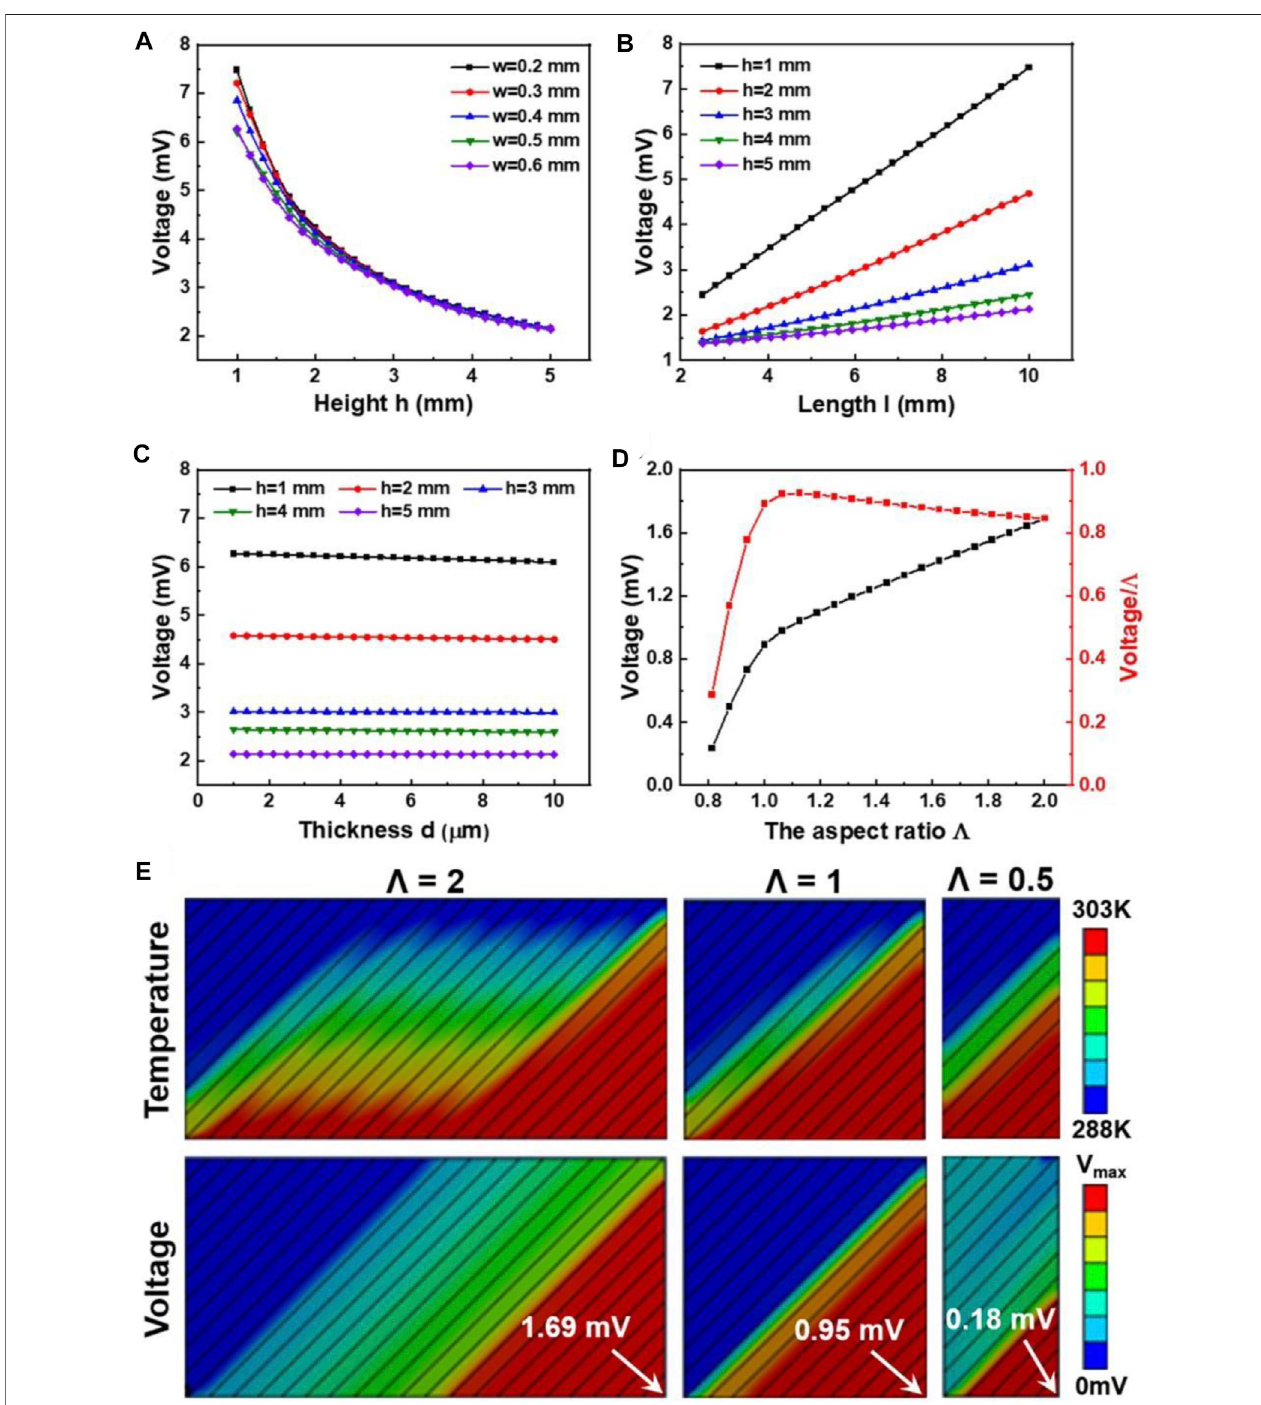
FIGURE 2 | Effect of geometrical parameters on the output performance of transverse thin- fi lm devices. (A) Output voltage curves with respect to h and w ; (B) outputvoltagecurveswithrespectto l and h ; (C) outputvoltagecurveswithrespectto d and h ; (D) Voltage and Voltage/ Λ withrespectto Λ ; (E) Temperaturedistribution and voltage distribution when Λ is 2, 1, and